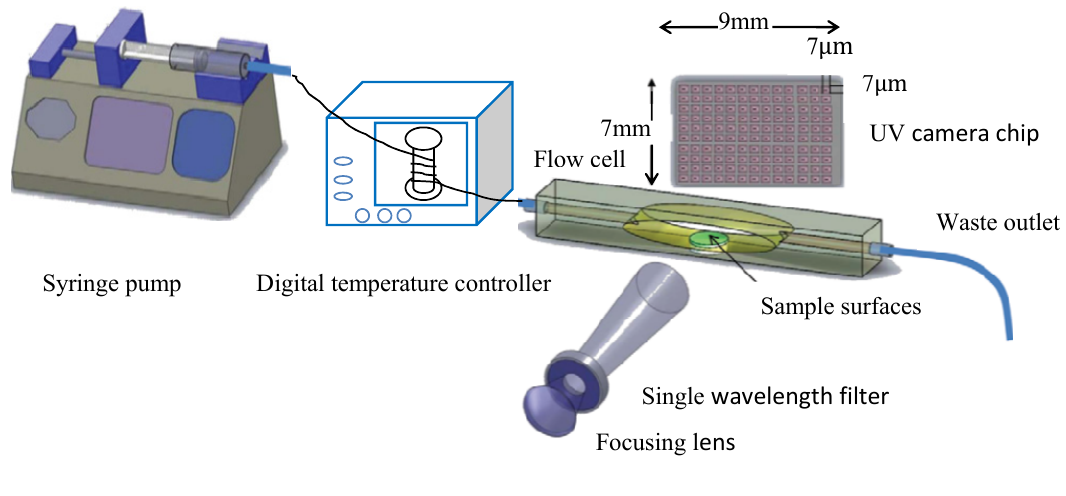
Figure 1. Schematic UV imaging dissolution